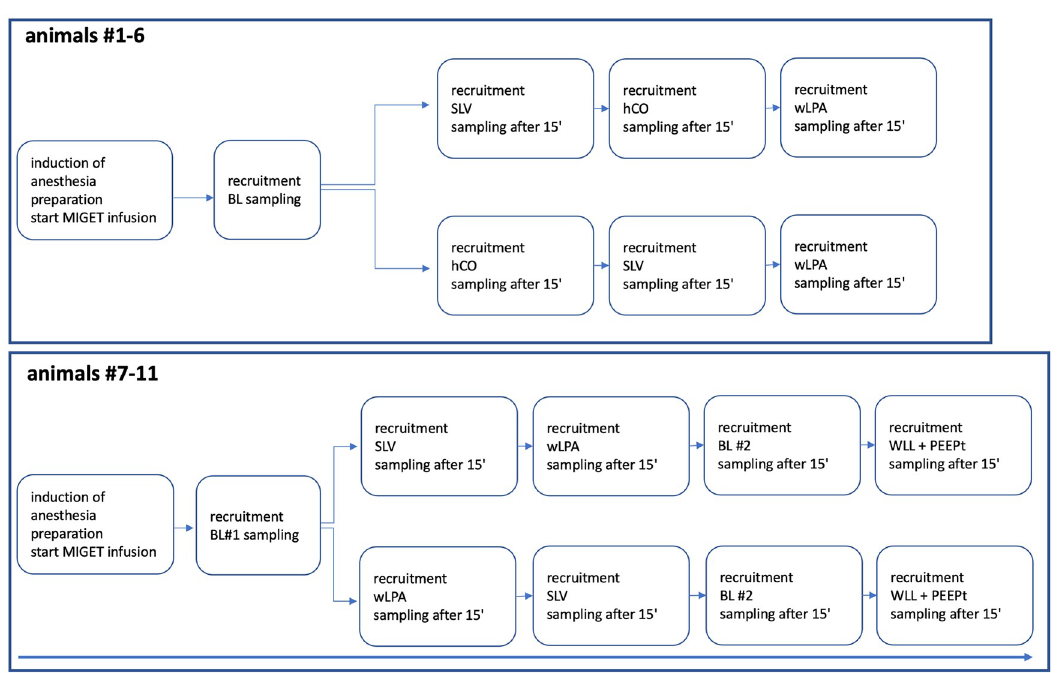
Fig 1. Experimental workflow. BL = baseline; SLV = single lung ventilation; hCO = high cardiac output; PEEPt = PEEP trial; wLPA = wedged left main pulmonary artery; WLL = whole-lung lavage; MIGET: Multiple inert gas elimination technique. The sequence of interventions